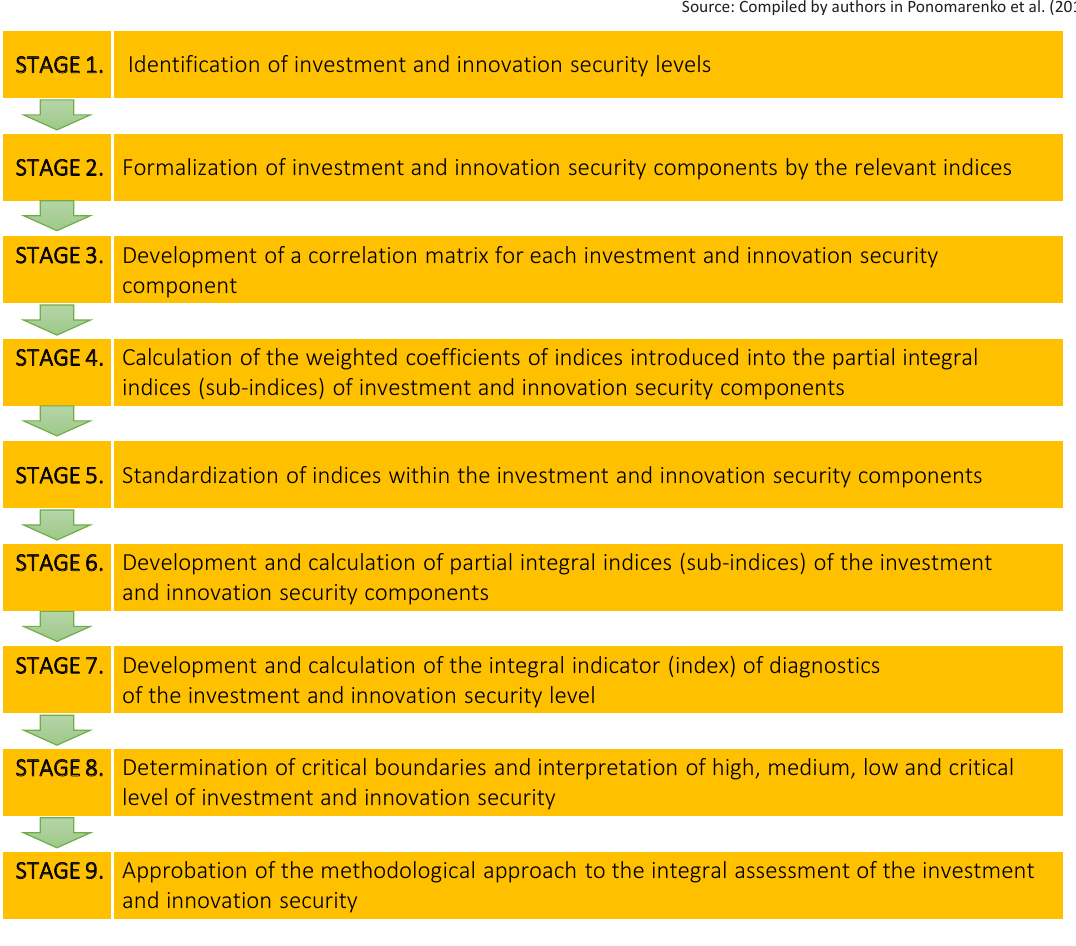
Figure 3. Logical scheme of the methodical